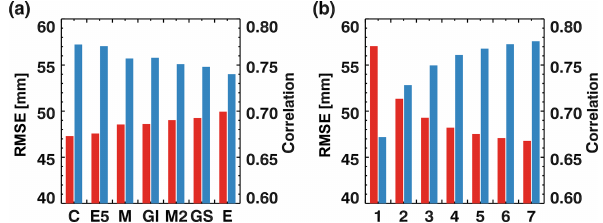
Figure 6. RMSE (red) and correlation (blue) of snow course mea- surements with various combinations of SWE products. (a) Average of all combinations that contain the specified individual product (C: Crocus; E5: ERA5; M: MERRA; Gl: GLDAS-2; M2: MERRA-2; GS: GlobSnow v2.0; E: ERA-Interim/Land) and (b) average of all combinations of N products as specified on the x